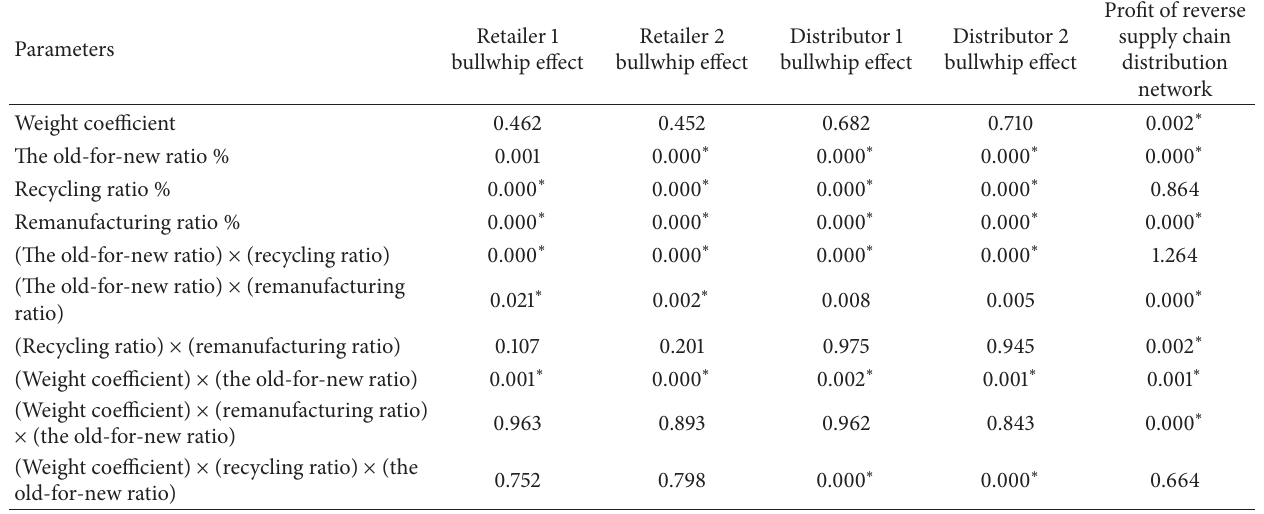
Table 6: The results of variance